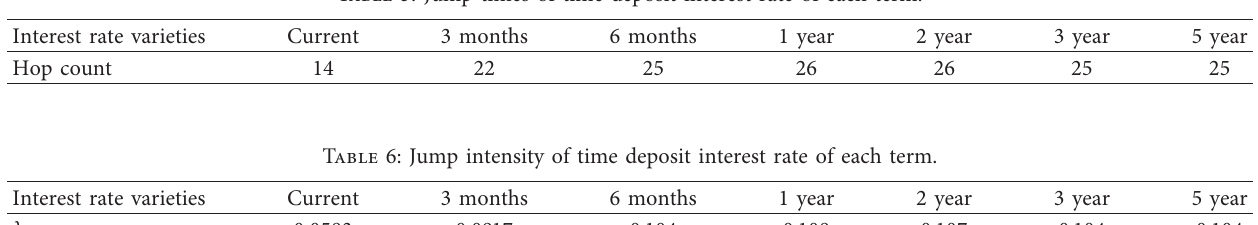
Table 5: Jump times of time deposit interest rate of each term.